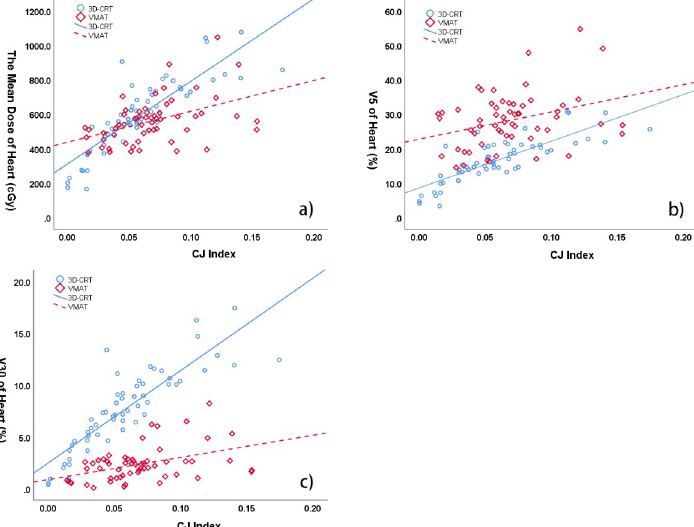
Fig 2. Correlation between CJ index and dose metrics of heart in 3D-CRT and VMAT. a) CJ index and the mean dose of heart (r = 0.857 for 3D-CRT, p < 0.01; r = 0.45 for VMAT, p < 0.01); b) CJ index and V5 of heart (r = 0.814 for 3D-CRT, p < 0.01; r = 0.328 for VMAT, p < 0.01); c) CJ index and V30 of heart (r = 0.869 for 3D-CRT, p < 0.01; r = 0.431 for VMAT, p < 0.01). The MLLD was 1420.31 ± 133.65 cGy in 3D-CRT group and 1356.09 ± 89.93 cGy in VMAT group (Table 2), and the difference between the two groups was statistically significant. As expected, 3D-CRT produced less low-dose radiation (V and V ) to the left lung than VMAT, 5 10 and more high-dose radiation to OAR (V , V and V ) than VMAT (Table 2). 20 30 40 In the VMAT group, PJ index was positively correlated with MLLD (r = 0.676, p < 0.01), V of left lung (r = 0.6, p < 0.01), V of left lung (r = 0.578, p 0.01), as well as V of left lung 20 30 40 (r = 0.594, p < 0.01) (Fig 3). Similarly, there was statistics significance in the correlation between PJ index and the absorbed dose of left lung in 3D-CRT plans, the correlation was found to be strongly between PJ index and MLLD (r = 0.697, p < 0.01), V (r = 0.568, 5 p < 0.01), V 10 (r = 0.663, p < 0.01), V 20 (r = 0.659, p < 0.01), V 30 (r = 0.66, p < 0.01), and V 40 (r = 0.691, p < 0.01) of left lung, respectively (Fig 3). Linear regression formulas were generated for mean dose of heart and left lung in both 3D-CRT and VMAT plans. The MHD formula of 3D-CRT group was MHD = 4826.59 × CJ Index+310.48 (R = 0.857, F = 163.77, P = 0.000), and that of VMAT group was MHD = 1789.29 × CJ Index+437.50 (R = 0.45, F = 14.23, P = 0.000). The intersection of the two formulas was that CJ index was 0.042 and MHD was 512.33 cGy. Since the slope of 3D-CRT group was steeper than that of VMAT group, it meant that when CJ index exceeded 4.2%, the MHD of 3D-CRT group would be greater than that of VMAT group. The MLLD formula of 3D-CRT group was MLLD = 2879.54 × PJ Index+999.79 (R = 0.697, F = 55.86, P = 0.000), and that of VMAT group was MLLD = 1411.79 × PJ Index+1091.88 (R = 0.676, F = 47.11, P = 0.000), and their intersection was PJ index equalled to 0.063 and MLLD equalled to 1180.46 cGy. For the slope of 3D-CRT group was steeper than that of VMAT group, it meant that when PJ index exceeded 6.3%, the MLLD of 3D-CRT group would be greater than that of VMAT group. Furthermore, the average MLLD of 3D-CRT group was 1420.31 cGy, and its corresponding PJ index was 0.146, suggesting that when PJ index was greater than 14.6%, the MLLD of 3D-CRT plan would much greater than that of VMAT plan.